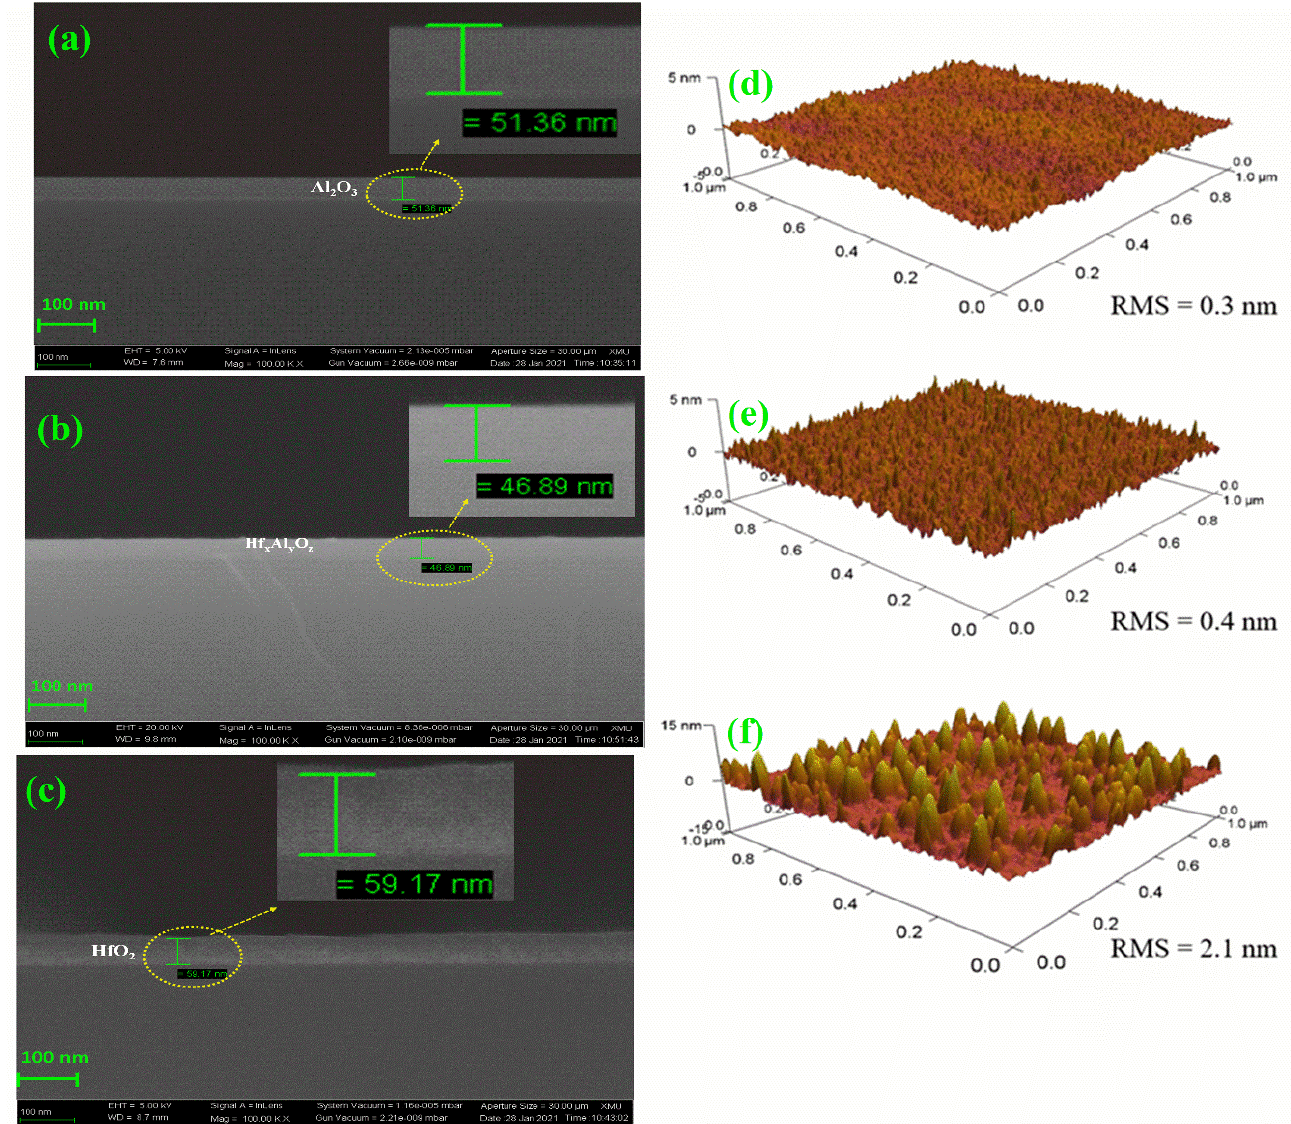
Figure 3. ( a – c ) The SEM and ( d – f ) the corresponding AFM images of Al 2 O 3 , Hf x Al y O z , and HfO 2 . Figure 4 shows the leakage current density of 51 nm-thick Al 2 O 3 , 47 nm-thick Hf x Al y O z , and 59 nm-thick HfO 2 thin films. Although the Hf x Al y O z nanolaminate film showed a lesser thickness than single HfO 2 , it exhibited a lower leakage current density. This result indicated that the introduction of Al 2 O 3 successfully enhanced the dielectric property of the films. The magnitude of the leakage current density of Hf x Al y O z nanolaminate was less than 10 − 7 A/cm 2 , which is in favor of the preparation of TFT with a high on-state current to off-state current ( I on / I off ). Capacitance vs. frequency curves for all cases were measured with frequencies from 20 to 2 × 10 6 Hz. As seen in Figure 4b, the capacitance values of 51 nm-thick Al 2 O 3 , 47 nm-thick Hf x Al y O z , and 59 nm-thick HfO 2 thin films were 85, 110, and 185 nF/cm 2 , respectively. The capacitance decreased slightly with increasing frequency, and it showed a stable capacitance for TFT